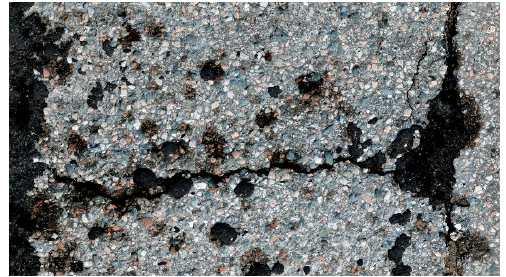
Figure 11. Orthoimage of defect 27 (plot